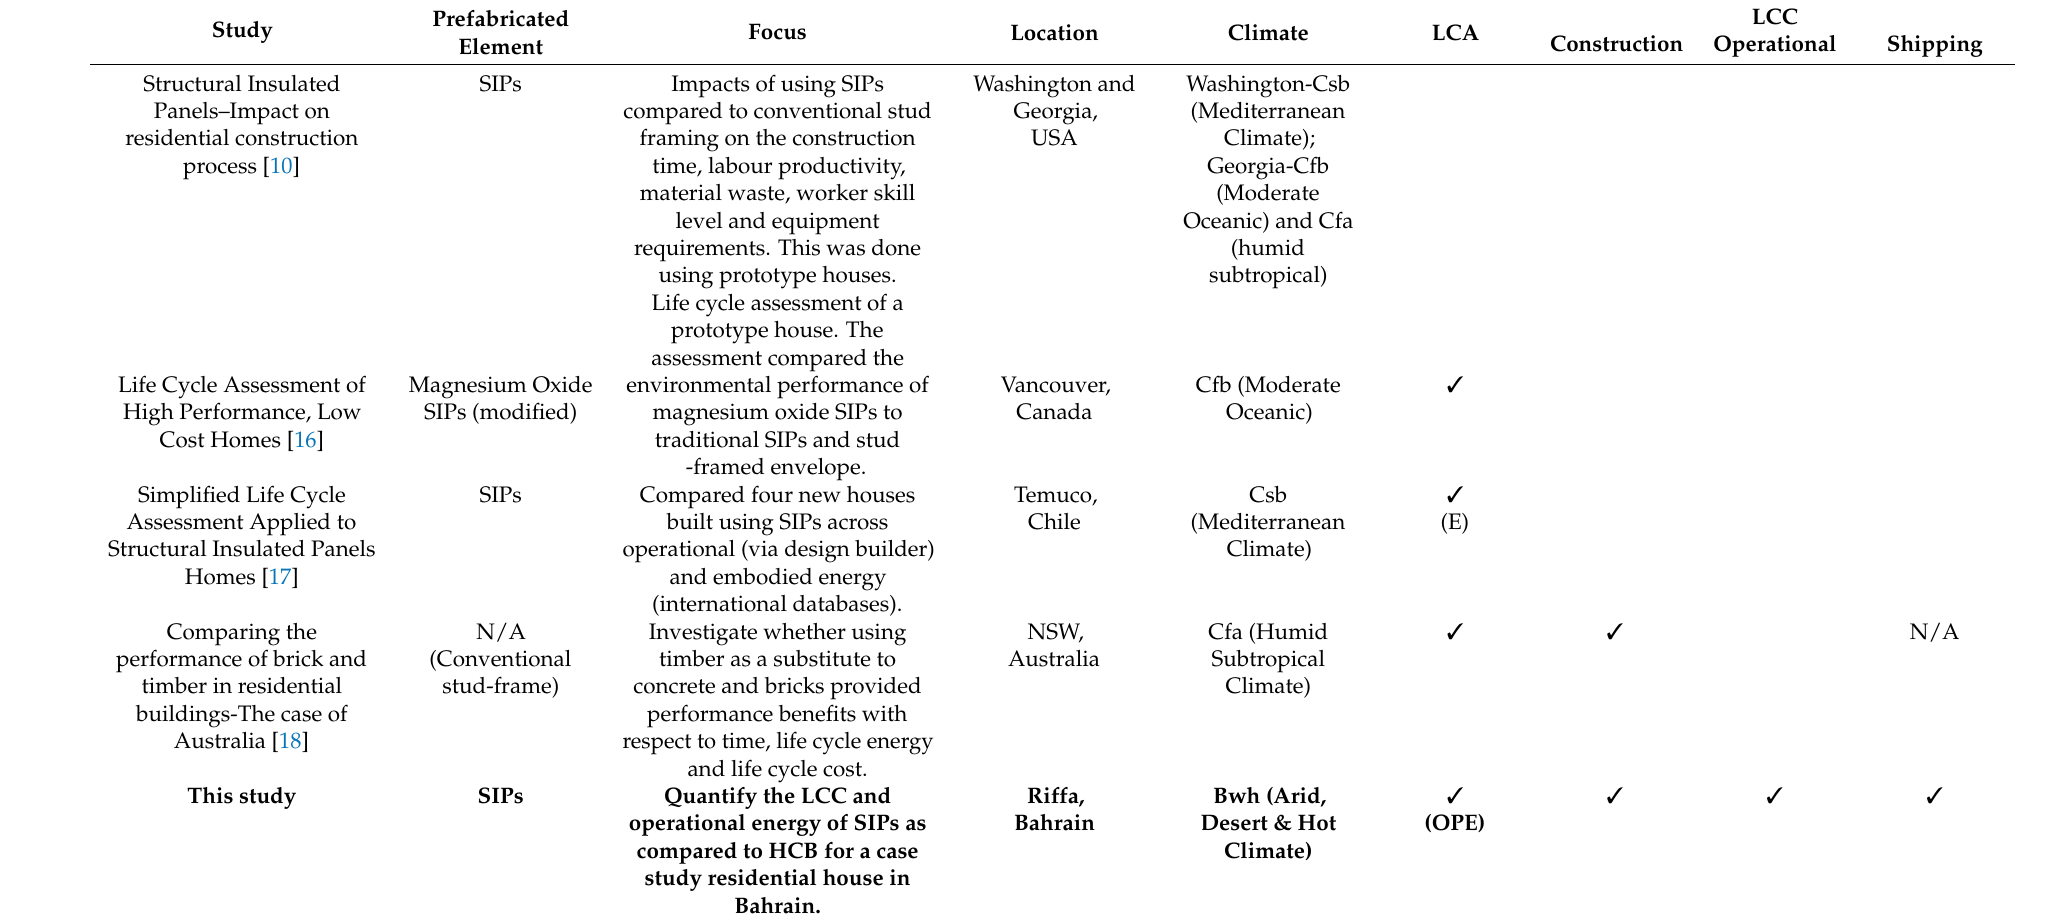
Table 1. Existing studies relevant to the scope of this